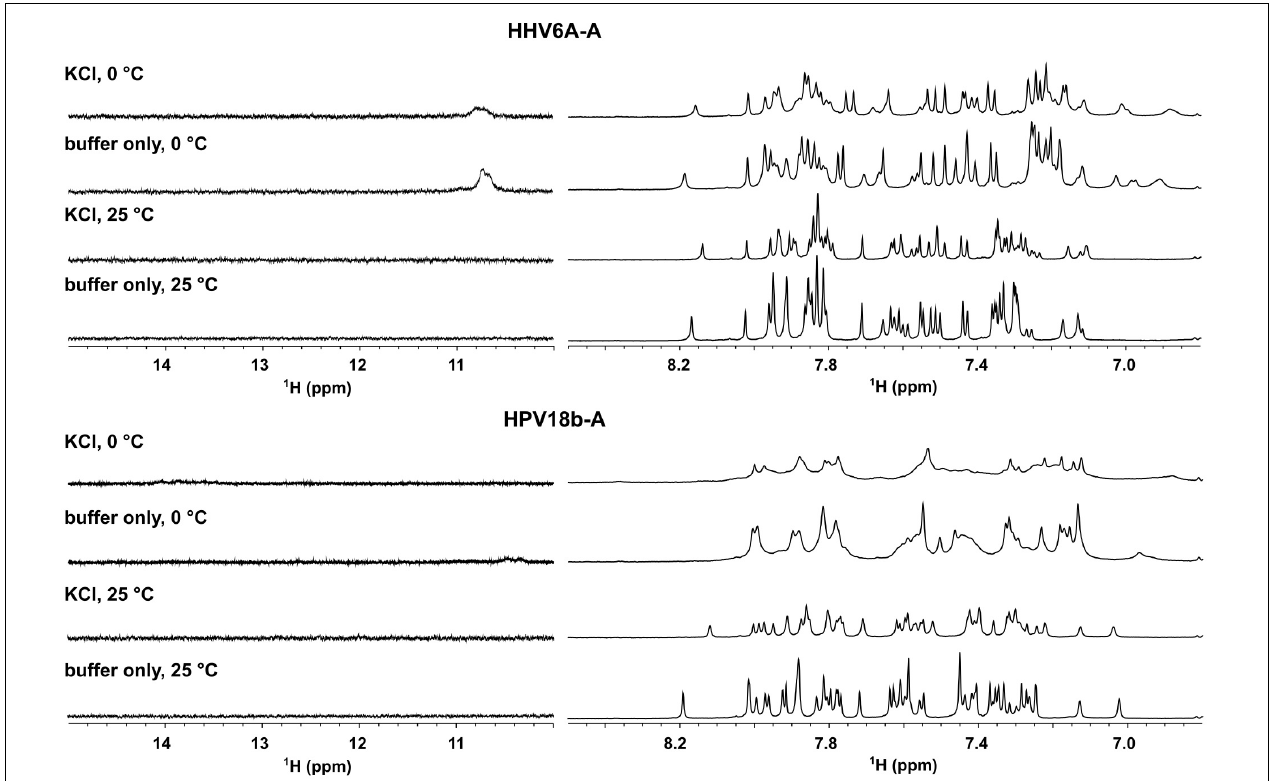
FIGURE 5 | Aromatic (right) and imino (left) region of 1D proton NMR spectra of HHV6A-A, and HPV18b-A oligonucleotides in lithium cacodylate buffer with and without 100 mM KCl. Spectra were recorded at 25 and 0 ◦ C.